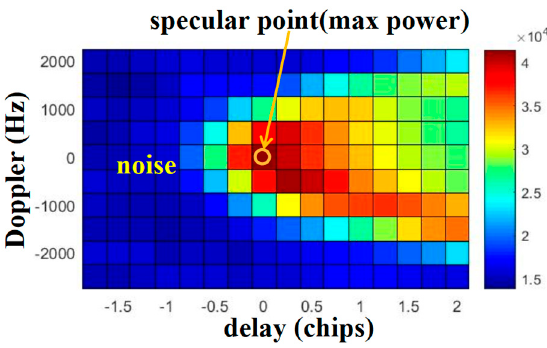
Figure 1. Bistatic radar scattering map.